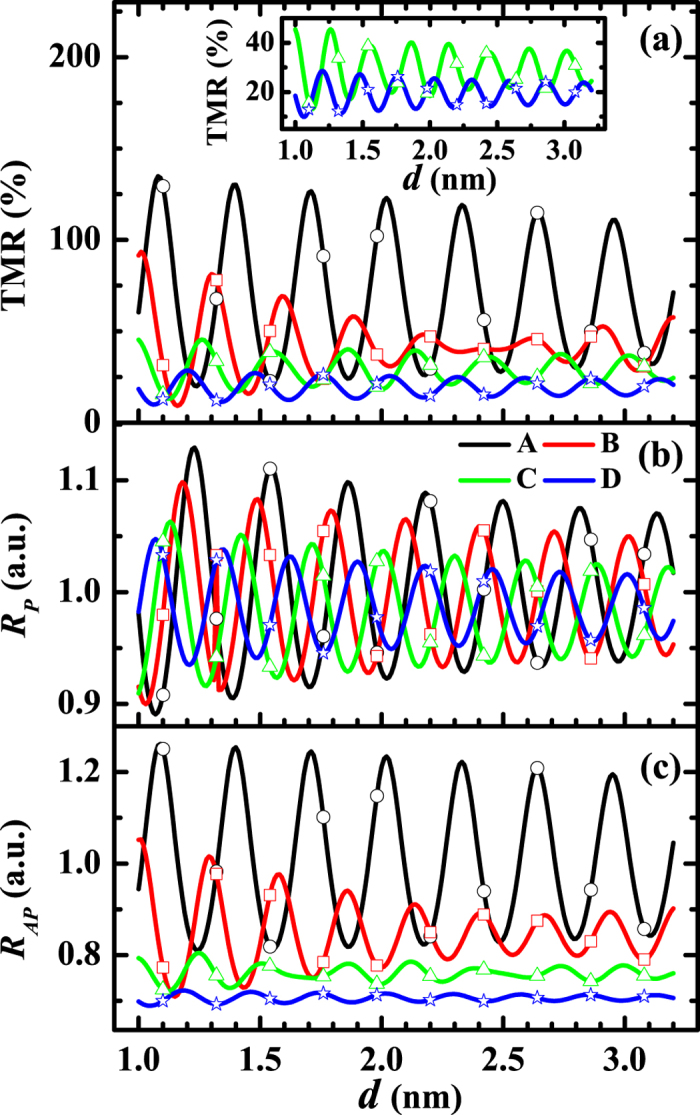
Thickness dependence of TMR, RP and RAP with the variation of Δ.(a) TMR, (b) RP and (c) RAP as functions of barrier thickness d where Kh = 2.116 × 1010 m−1, v(Kh) = 16 eV and μ = 11 eV. The curves A, B, C, and D correspond to Δ = 10 eV, 9 eV, 8 eV and 7 eV, respectively. The data corresponding to the discrete layers of the grating barrier are marked with open symbols: curve A is marked by open circle, curve B is marked by open square, curve C is marked by open triangle, and curve D is marked by open star. Here, the inset is an enlarged view of the curves C and D.